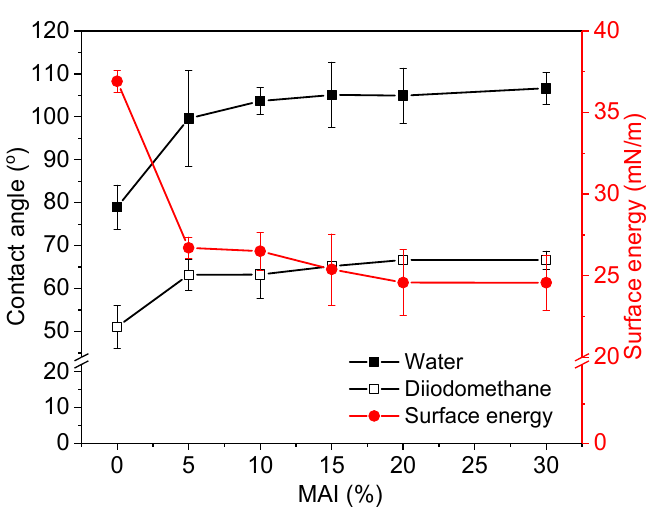
Figure 9. Water and diiodomethane contact angle and surface energy of SPSAs as a function of MAI content.